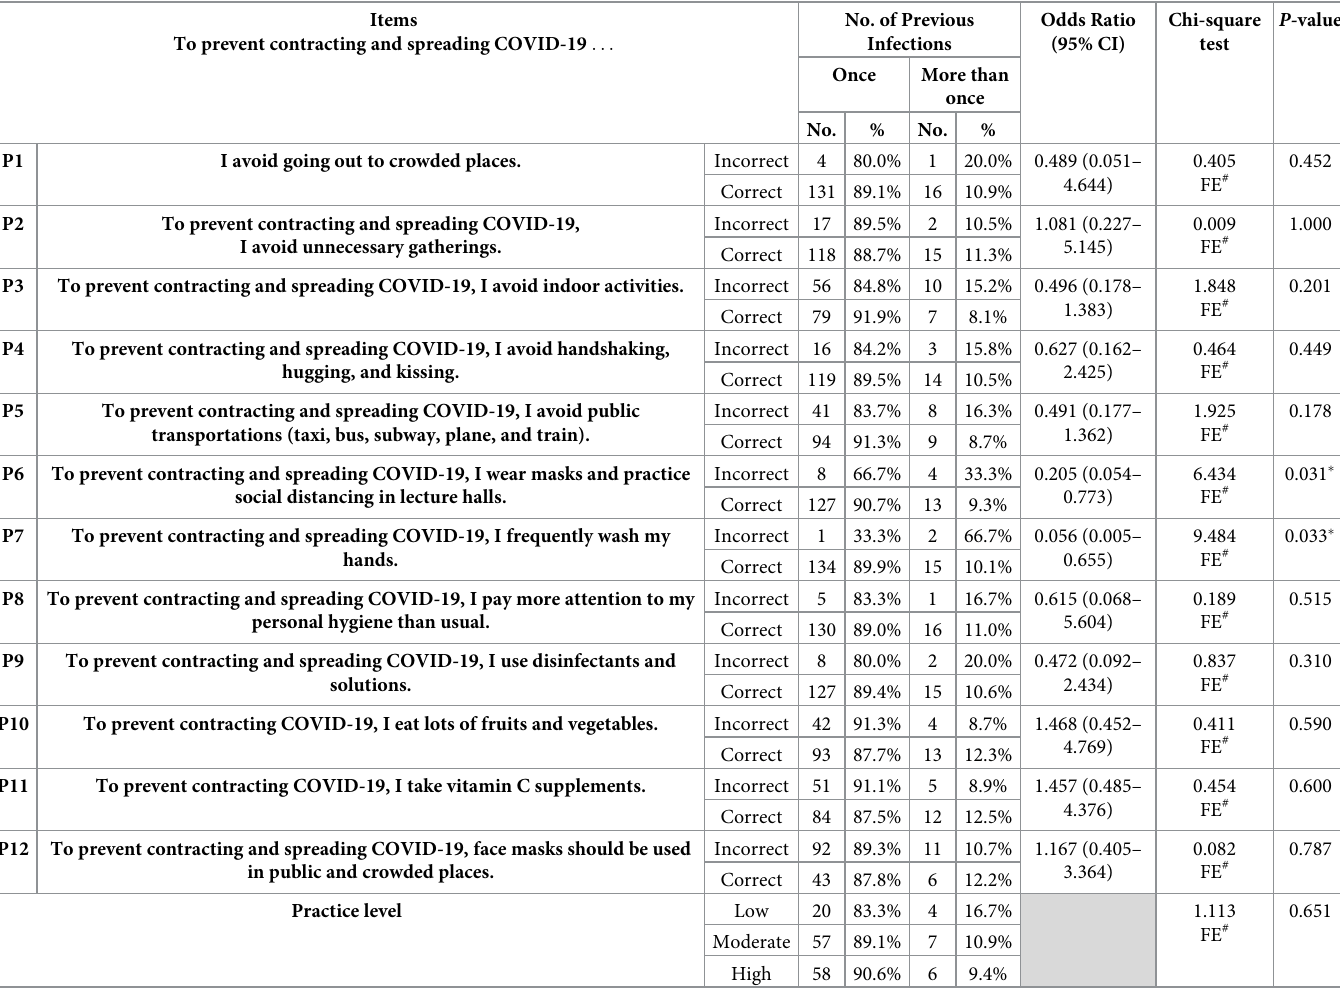
Table 4. Relationship between frequency of infection among medical students and practice related to precautionary measures against COVID-19 (n = 151). Items To prevent contracting and spreading COVID-19